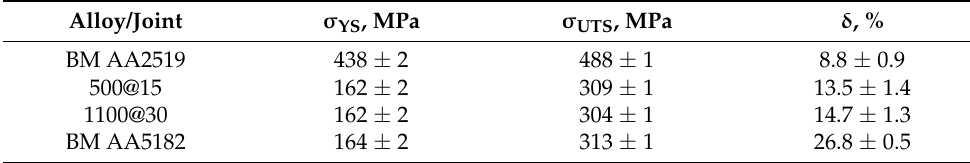
Table 3. Tensile properties of base materials and dissimilar